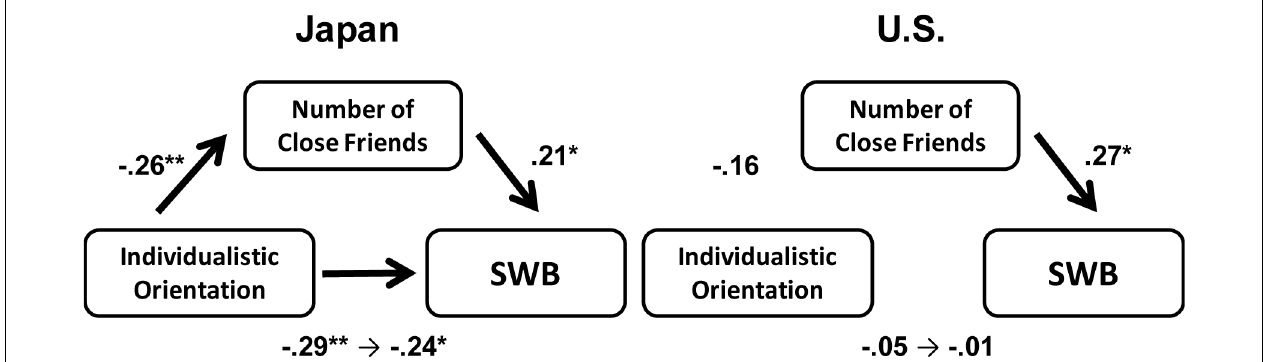
FIGURE 3 | Mediation effect of the number of close friends between individualistic orientation and SWB in Japan and the U.S. (Study 1). Path coefficients on the left side of the arrows from individualistic orientation to SWB indicate standardized regression coefficients when individualistic